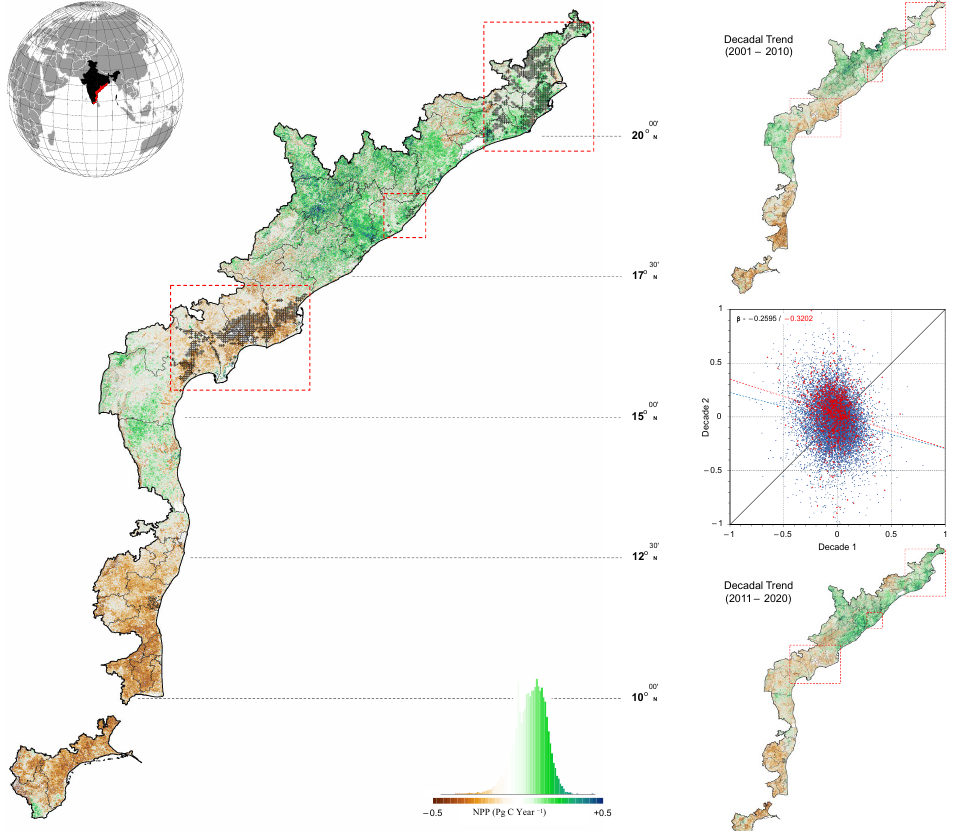
Figure 7. The spatial trend of NPP with possible sensitive zones to AOD for the ECP. Sensitive areas of NPP to AOD are highlighted with stippling ( p < 0.05) and boxes with red dashed. Correlation between the decadal trend, D 1 for 2001–2010 and D 2 for 2011–2020 is provided along with the inset map. The red scatters represent the spatial stippling, and its corresponding slope ( β ) is provided in red. The histogram represents the distribution of NPP pixels for the overall trend (similarly, the spatial trend for GP and MGP is provided in supplementary document S2). The reader is referred to the online version of this figure for better visual